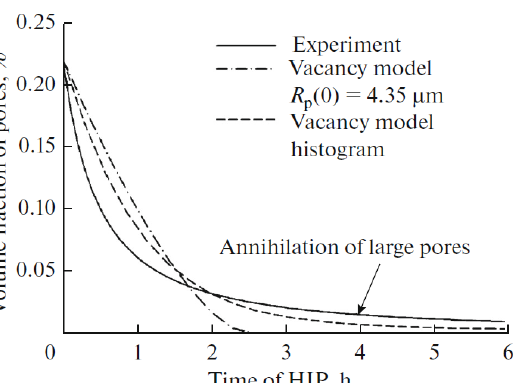
Figure 11. Kinetics of pore annihilation in heat-treated CMSX-4 alloy during HIP at 1288 °C/103 MPa [45] .